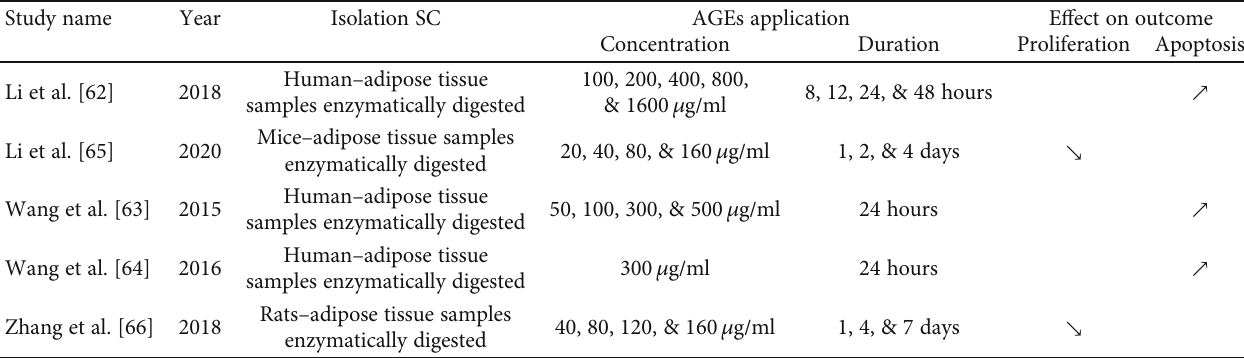
Table 4: Summary of included studies using ADSCs. Summary of the isolation procedure and sampling, AGEs concentration, application duration, and e ff ect on outcome measurement proliferation and